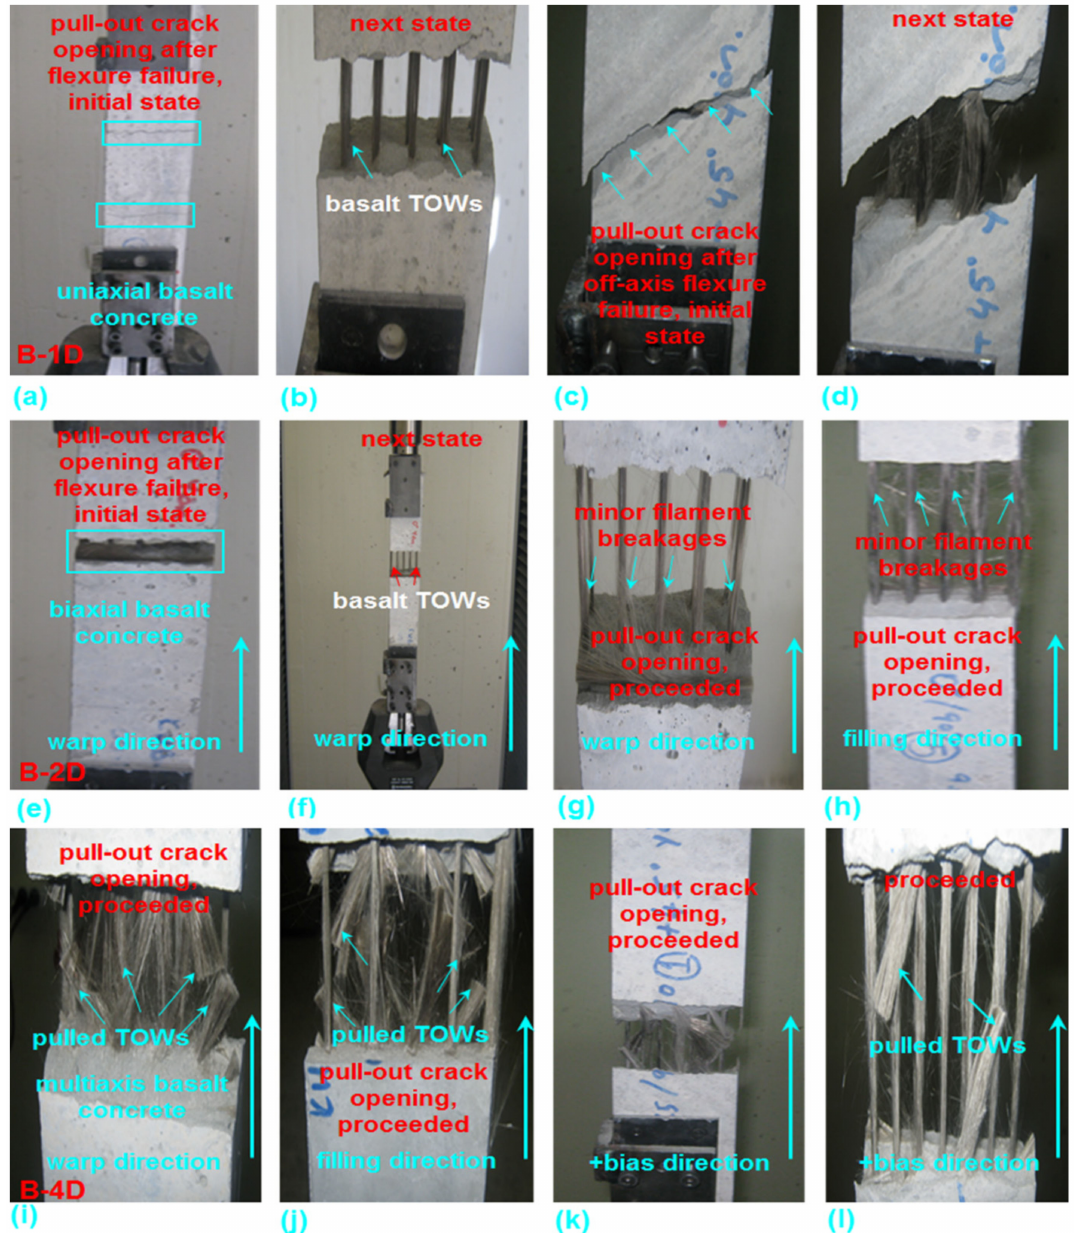
Figure 20. Pull-out of multiaxis 3D basalt concretes. ( a ) Initial state of pull-out crack opening after Figure 1D; ( b ) next state (B-1D); ( c ) initial state (B-1D); ( d ) next state (B-1D); ( e ) initial state (B-2D); ( f ) pull-out fixture (B-2D); ( g ) next step in warp (B-2D); ( h ) next step in filling (B-2D); ( i ) crack opening in warp (B-4D); ( j ) crack opening in filling (B-4D); ( k ) initial state in +bias direction (B-4D) and ( l ) next state in +bias direction (B-4D) (digital photo